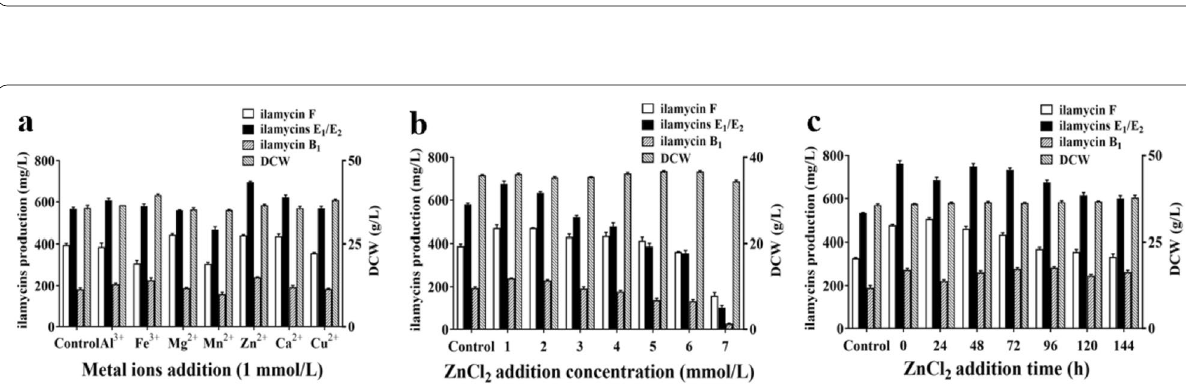
Fig. 5 Effect of metal ions addition ( a ), ZnCl 2 addition concentration ( b ), and ZnCl 2 addition time ( c ) on DCW and ilamycins